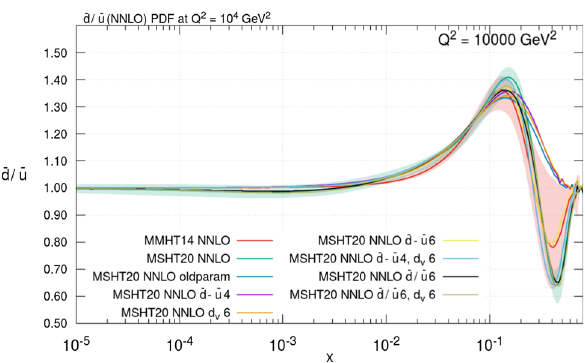
Fig. 43 ¯ d / ¯ u PDF at Q 2 = 10 4 GeV 2 at NNLO showing how incre- menting the old parameterisation to the new parameterisation affects the PDFs